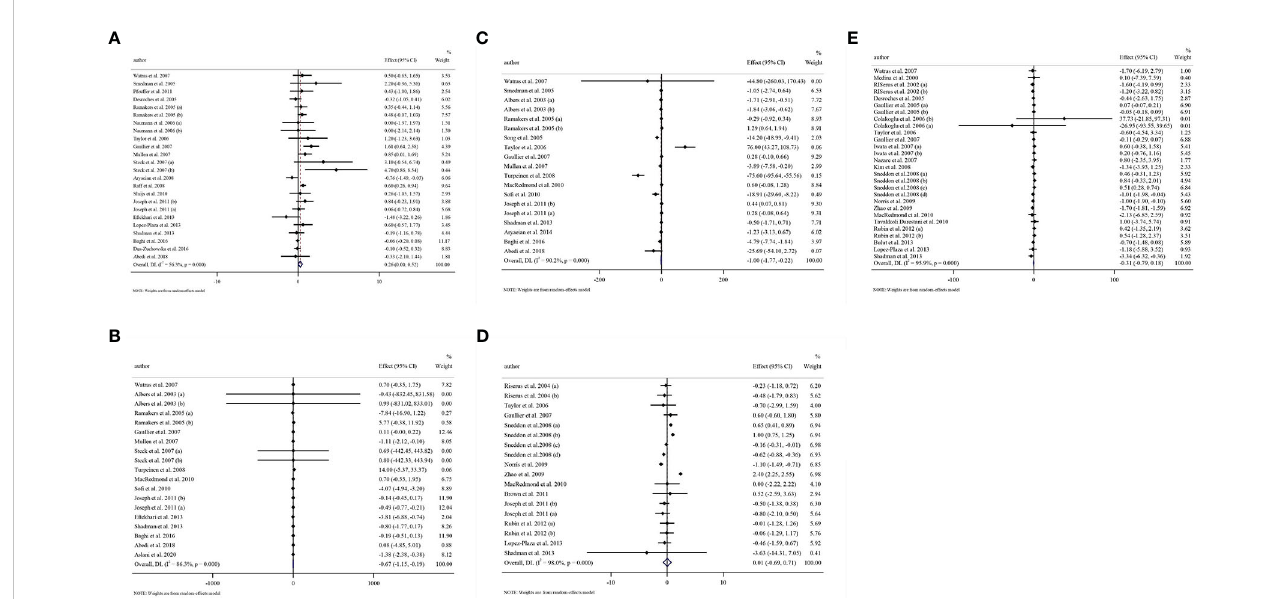
FIGURE 2 Forest plot detailing weighted mean difference and 95% con fi dence intervals (CIs) for the effect of CLA consumption on (A) CRP (mg/L), (B) IL-6 (pg/ml), (C) TNF- a (ng/ml), (D) adiponectin (µg/ml), and (E) leptin (ng/ml). Horizontal lines represent 95% CIs. Diamonds represent pooled estimates from random-effects analysis. WMD, weighted mean difference; CI, con fi dence interval; CLA, conjugated linoleic acid; CRP, C-reactive protein; IL-6, interleukin 6; TNF- a , tumor necrosis